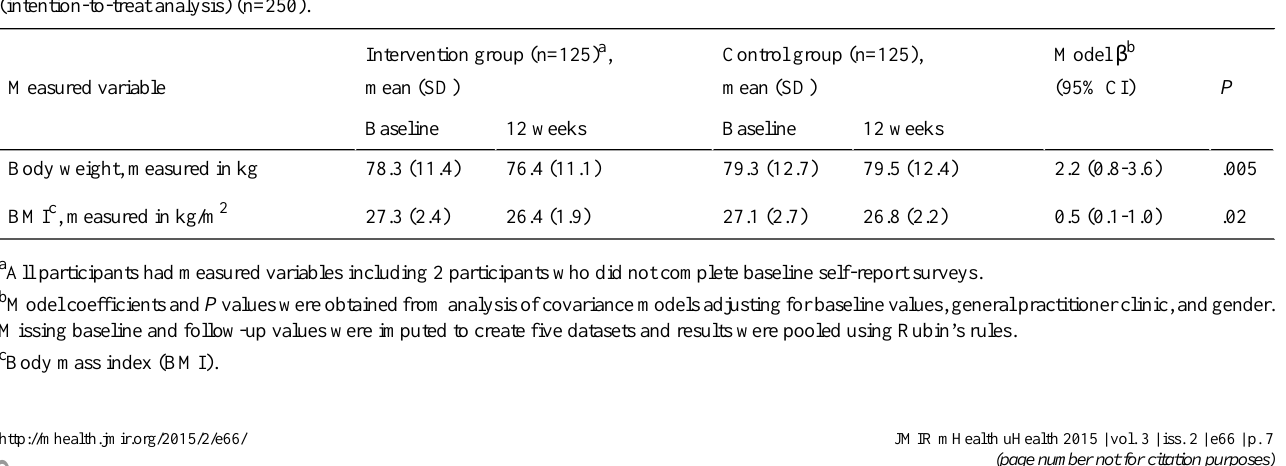
Table 2. Effect of the TXT2BFiT program on measured weight and BMI outcomes for all randomized participants in the study by allocation (intention-to-treat analysis) (n=250).